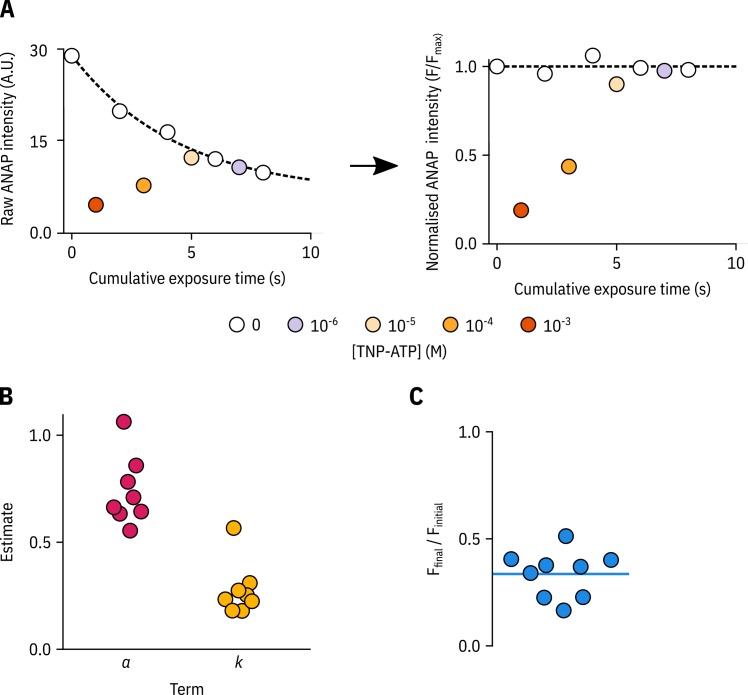
Bleaching correction for PCF experiments.(A) Raw ANAP fluorescence intensities (left) and corrected ANAP fluorescence intensities (right) from a representative PCF experiment with Kir6.2*-GFP + SUR1 plotted against the exposure time. The fit to Equation 1 is shown as a black dashed line. To minimise artifacts from our bleaching corrections we performed experiments from both high-to-low and low-to-high TNP-ATP concentrations. (B) The parameters from fits to Equation 1 for each PCF experiment in Figure 2 are shown individually. (C) The fraction of ANAP fluorescence intensity remaining at the end of each PCF experiment in Figure 2 is shown by dividing the raw ANAP intensity of the last exposure by that of the first. The mean fractional remaining intensity of 0.34 is shown as a horizontal blue line.